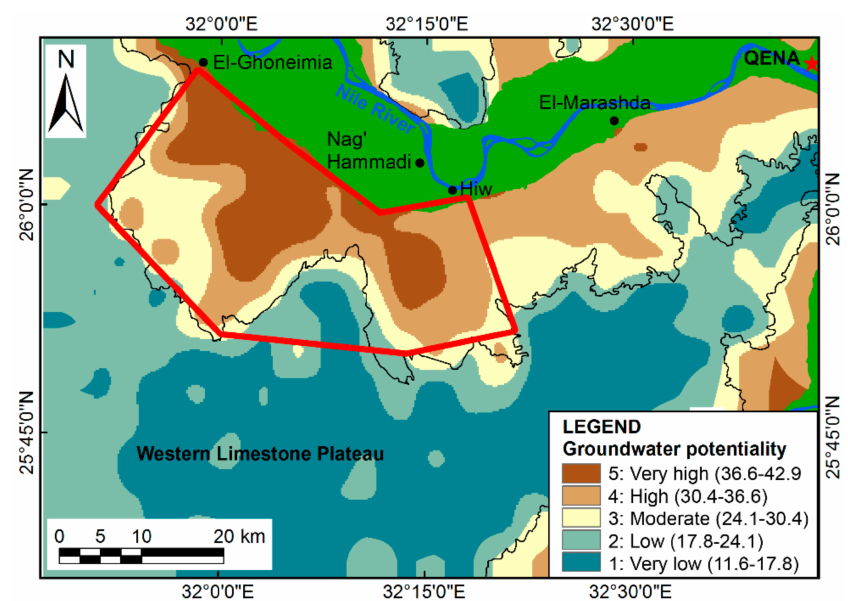
Figure 13. Groundwater recharge potentiality map of the study area (red boundary) inferred from remote sensing data and GIS